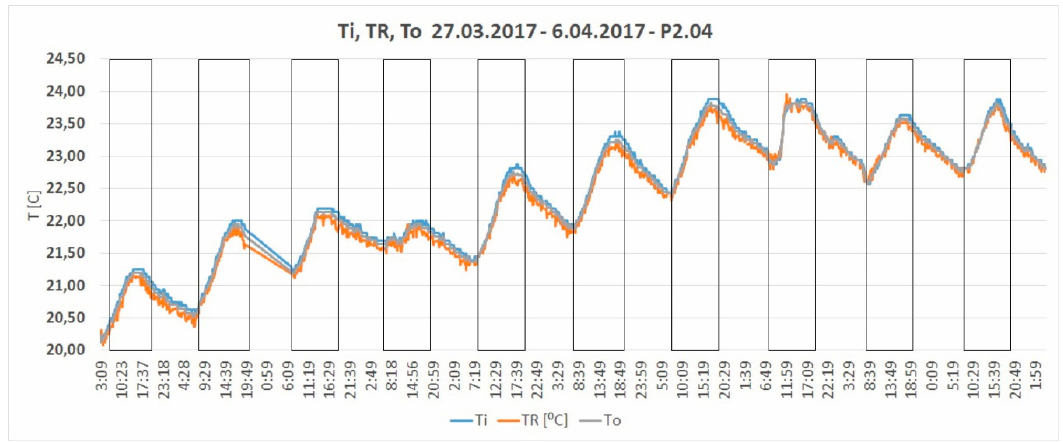
Figure 13. Wavelength of indoor air temperature changes in room P2.04 ( T i ) and mean radiation temperature (TR).